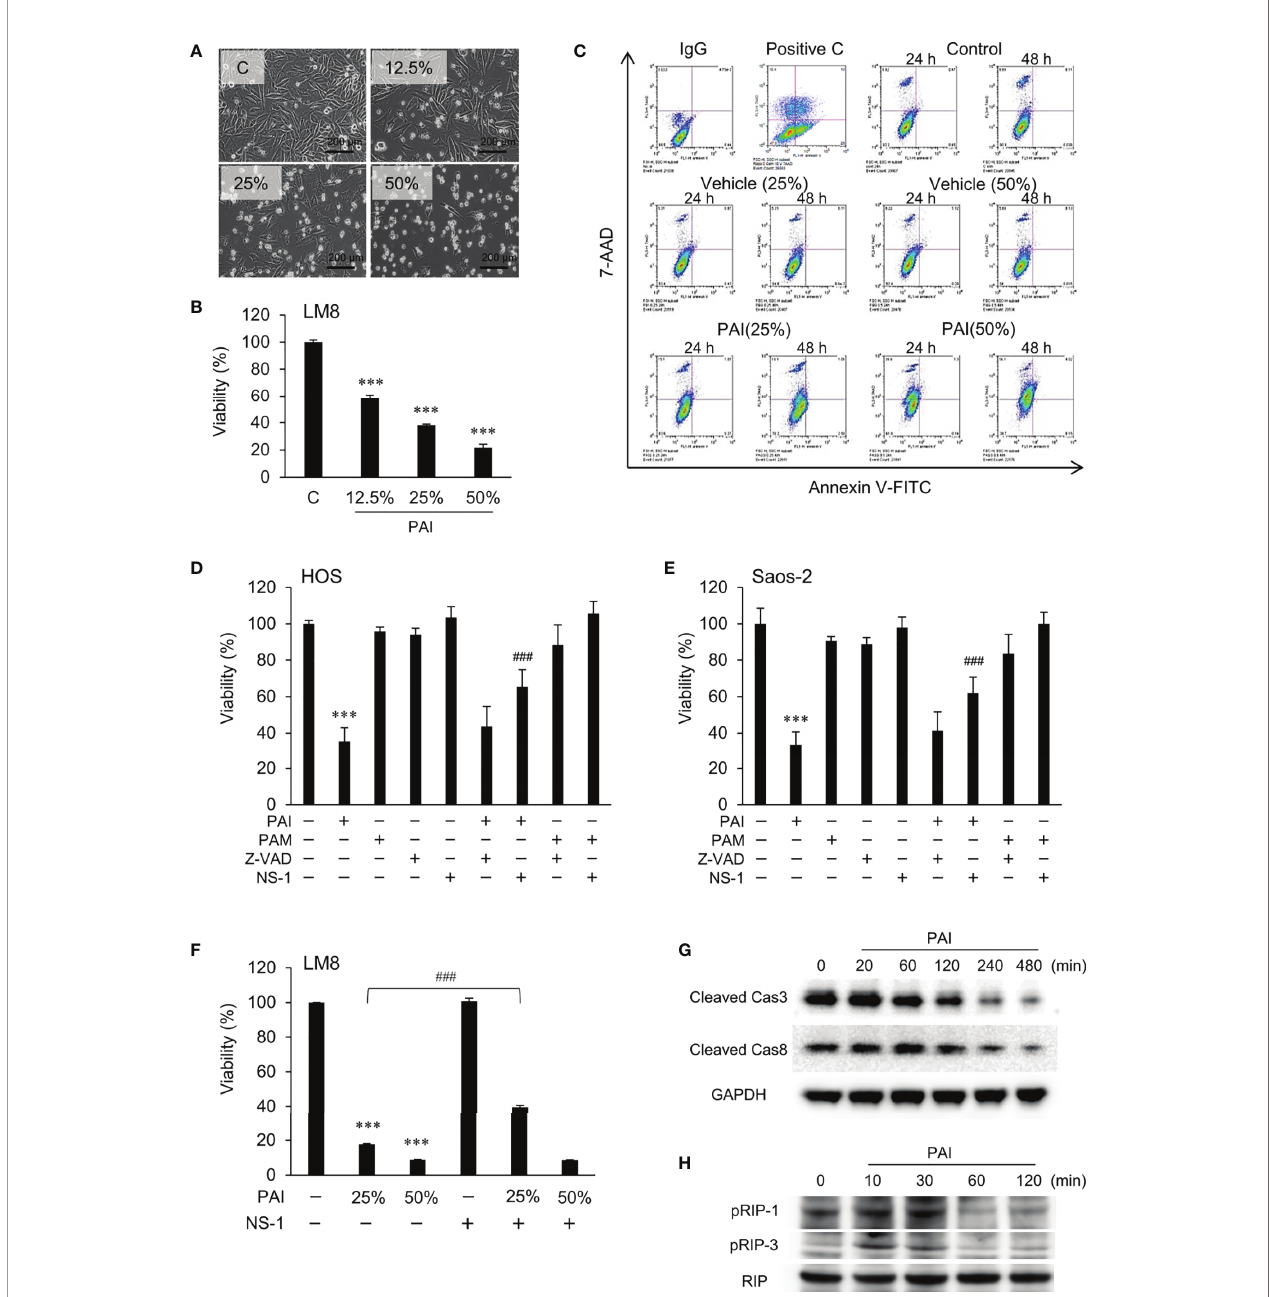
FIGURE 2 | PAI induces necroptosis. (A) LM8 cells were treated with varying concentrations of PAI for 18 h and observed by light microscopy. Bar = 200 m m. The cells became less adherent, shrunken, and round in a dose-dependent manner. (B) LM8 (5 × 10 3 cells) were treated with the indicated PAI concentrations for 72 h and analyzed for viability using the WST-8 cell growth assay. Data are the mean ± SD (n = 4). Data were analyzed by one-way analysis of variance followed by Tukey ’ s post hoc test. *** P < 0.001 vs. control treated with vehicle. (C) Cells were treated with PAI (25% or 50%) and the vehicle for 24 or 48 h, stained with Annexin V-FITC and 7-AAD, and analyzed by fl ow cytometry. Gemcitabine was used as a positive control for apoptosis induction (Positive C). The rate of cell necrosis and cell apoptosis is shown in Supplementary Figures 1A, B . (D – F) (D) HOS, (E) Saos-2 or (F) LM8 cells were treated with PAI (25% or 50%) or PAM (25%) alone or in combination with ZVAD-FMK (ZVAD, 10 m M) or necrostatin-1 (NS-1, 30 m M) for 72 h and cell viability was measured by the WST-8 assay. Data are the mean ± SD (n = 3). Data were analyzed by one-way analysis of variance followed by Tukey ’ s post hoc test. *** P < 0.001 vs. control. ### P < 0.001 vs. PAI alone. (G, H) The status of Caspase-3, Caspase-8, RIPK1, and RIPK3 activity in the cells. LM8 cells were treated with PAI (50%) for the indicated time and then analyzed for the expression of cleaved caspase-3, cleaved caspase-8, phosphorylated RIP-1, and phosphorylated RIP-3 by western blotting analysis using speci fi c antibodies. GAPDH and RIP were used as the loading control. See Supplementary Figures 1C, D , 2A, B for examples of uncropped images and quanti fi cation for each